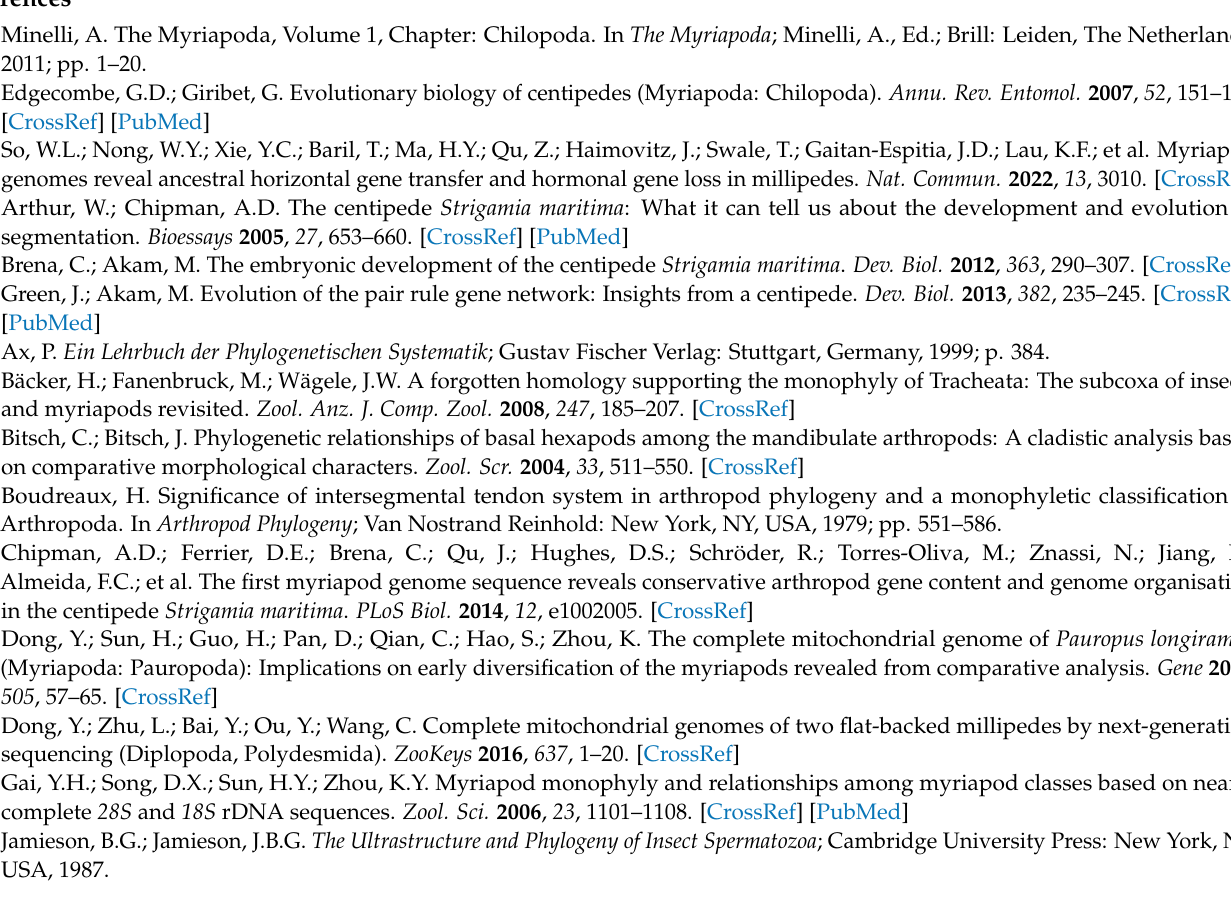
Figure S2: Predicted secondary structure of the 22 tRNAs in the M. marmoratus mitogenome (dashes ( − ) indicate Watson–Crick base pairing); Table S1: GenBank accession numbers for taxa used in this study [12,13,40,40,41,43–45,47,58–76]; Table S2: Optimal partition strategy and evolutionary models used in phylogenetic analyses; Table S3: Mitochondrial genome organization of S. subspinipes ; Table S4: Mitochondrial genome organization of M. marmoratus